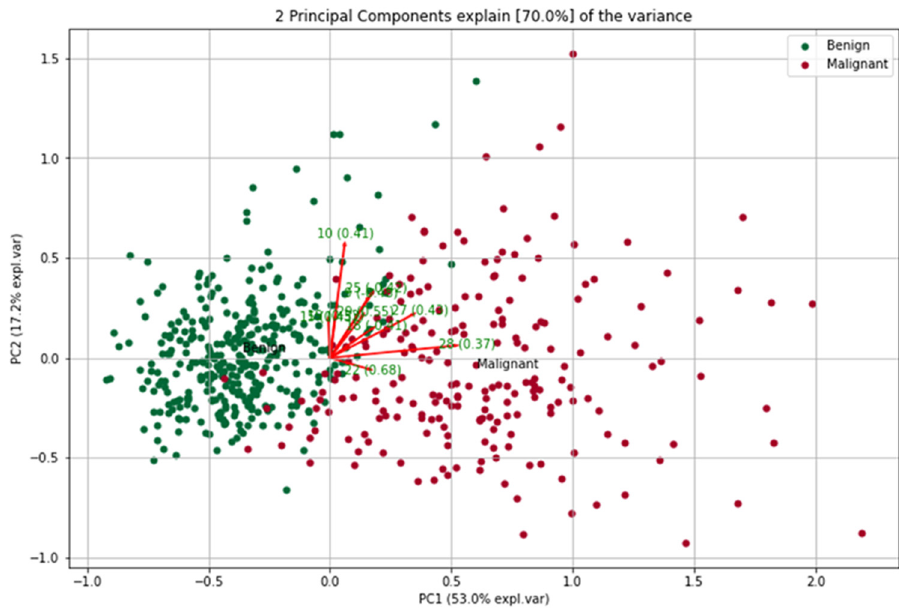
Figure 2: Visualization of the breast cancer dataset with reduced dimensions using PCA